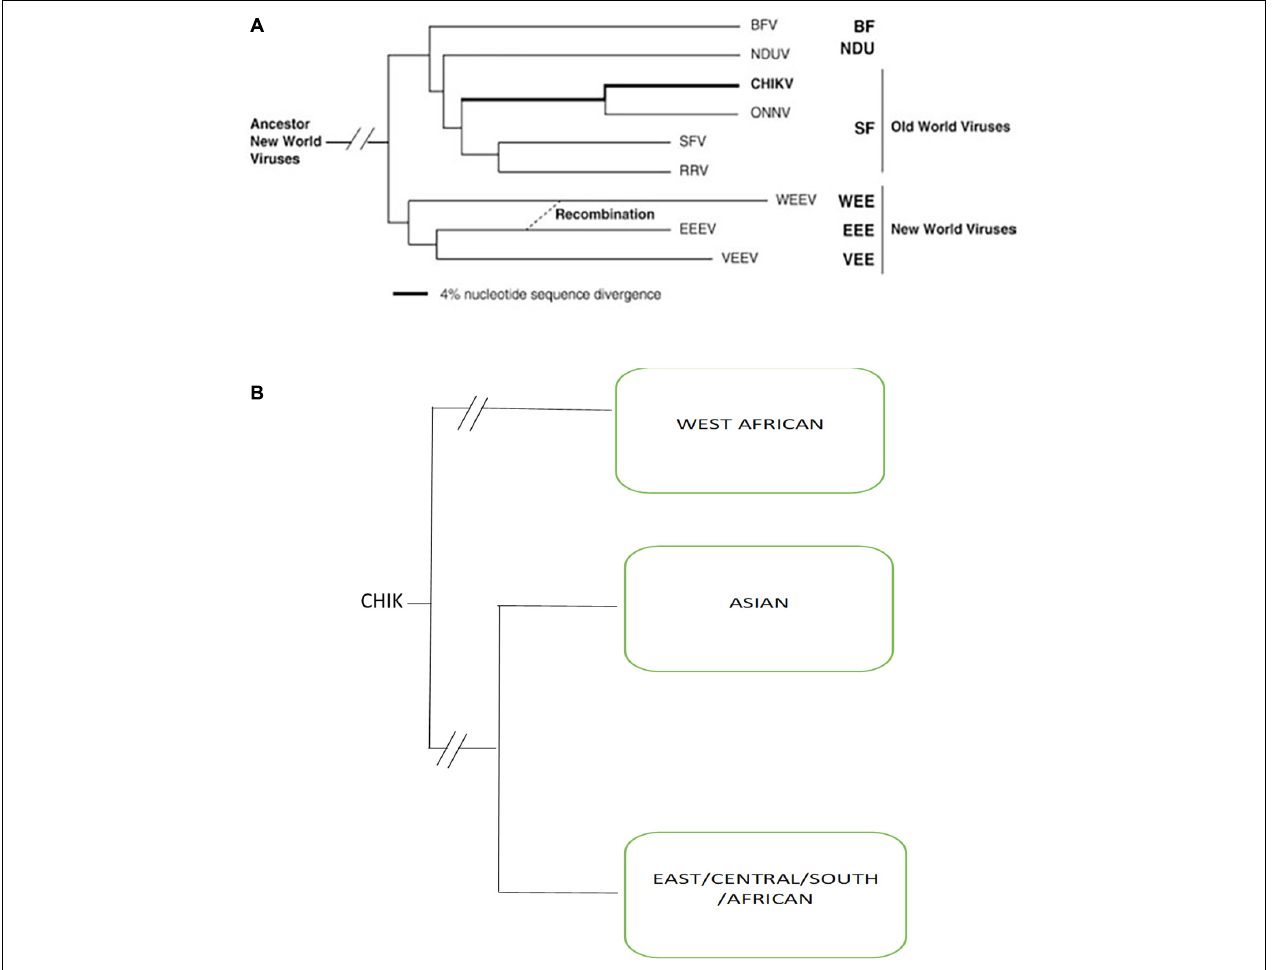
FIGURE 1 | (A) Simplified Phylogenetic tree of all Alphaviruses generated from partial E1 envelope glycoprotein gene sequences by using the neighbor-joining program Adapted from Powers et al. (2001) (BF, Burma Forest virus; CHIKV, chikungunya virus; SF, Semliki Forest; WEE, western equine encephalitis; EEE, eastern equine encephalitis; VEE, Venezuelan equine encephalitis; NDUV, Ndumu virus; ONNV, o’nyong’nyong virus; RRV, Ross River virus). (B) Phylogenetic tree of three genotypes of chikungunya